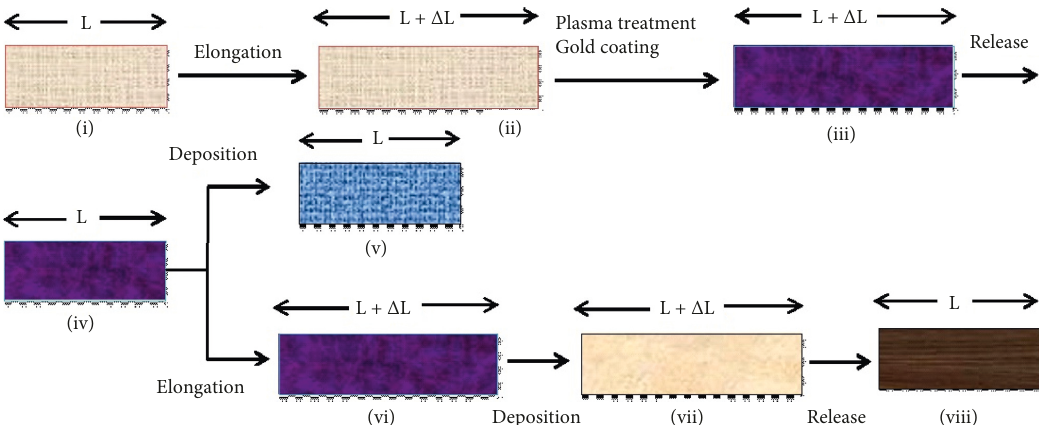
Figure 11: Diagram measures confirmed to organize buckled Au or polypyrrole PPy-pTS films on SIBS substrate of those products. Buckled PPy-pTS assembly involves the surface treatment, gold (Au) sputter coating, relaxation of the pre-strained SIBS substrate, and polypyrrole (PPy) electro-deposition. 2D buckled polypyrrole PPy-pTS film was electrodeposited on the re-elongated Au-layered substrate, achieved after the reduction in the substrate. (a) and (b) Buckled Au film (iv); (c) and (d) buckled polypyrrole (PPy)-pTS film (v); (e) and (f) 2D buckled polypyrrole (PPy) pTS film (viii). Inset, side outlook of PPy-pTS film showing the minor